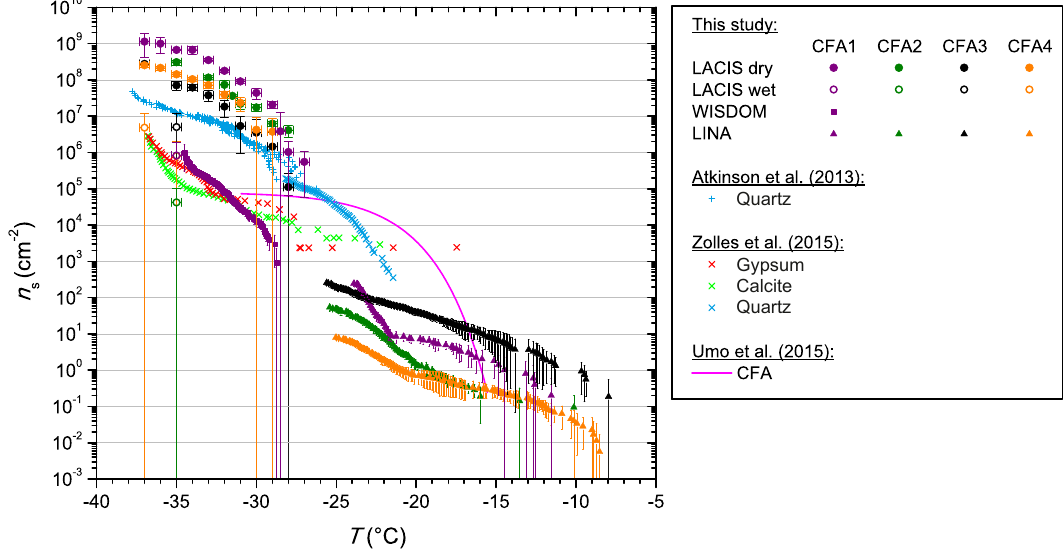
Figure 4. n s from LACIS measurements with dry- and wet-generated 300nm particles. n s from WISDOM measurements with the fine CFA fraction and n s from LINA measurements with bulk material are included for comparison. Measurements with gypsum, calcite, and quartz are taken from Zolles et al. (2015) and Atkinson et al. (2013), measurements with a CFA sample of different origin from Umo et al.